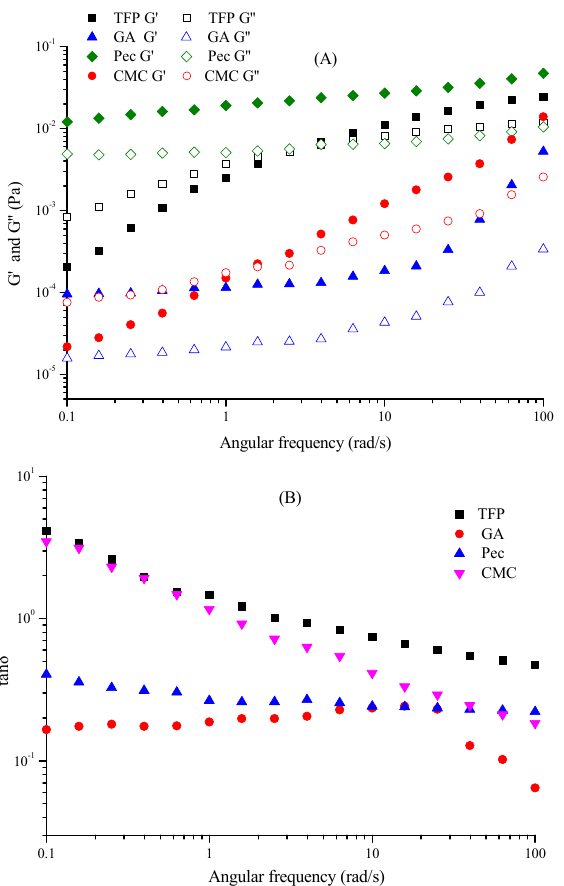
Figure 7. The G’ (solid symbols) and G” (open symbols) ( A ) and tan δ ( B ) of different emulsions Figure 7. The G (cid:48) (solid symbols) and G (cid:48)(cid:48) (open symbols) ( A ) and tan δ ( B ) of different emulsions with with the relationship of angular frequency. the relationship of angular frequency.